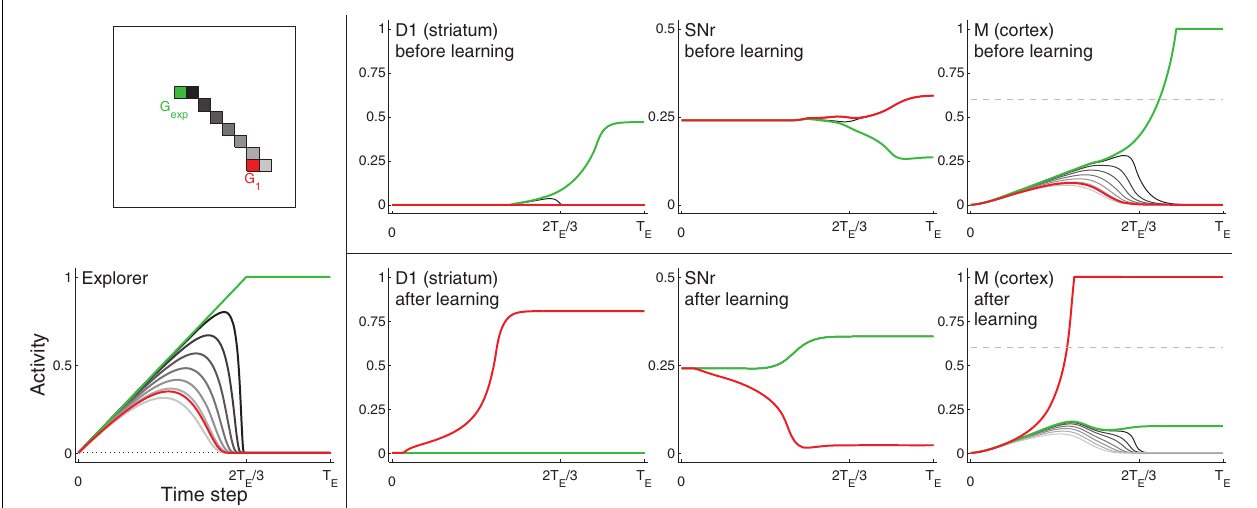
FIGURE 3 | Example neural activity for selected neurons from D1, SNr, and Cortex (M) at different points in training. Neurons are colored according to their spatial location in the grid ( top left ). The red neuron corresponds to the center of target G 1 , the green neuron corresponds to the location of G exp (focus of excitation in Explorer), which is not within the target area. Other neurons, most of which are located in between the G 1 and G exp , are colored in gray (darker gray neurons are closer to G exp ).